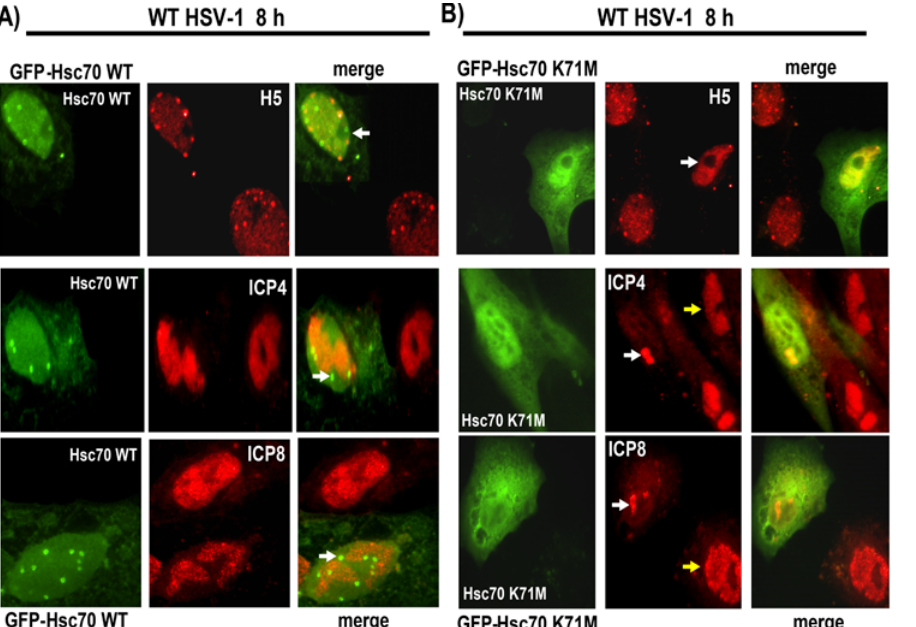
Figure 9. An Hsc70 Dominant Negative Mutant Can Prevent RNAP II Phospho-serine 2 Degradation and Hsc70 Focus Formation. A) Vero cells were transfected with pGFP-Hsc70 and were subsequently infected with WT HSV-1 for 8 h. Cells were stained with H5, anti-ICP4 or anti-ICP8 antibodies. GFP fluorescence was viewed directly. Arrows point to Hsc70 foci. B) Vero cells were transfected with the dominant negative mutant GFP- Hsc70K71M and then infected with WT HSV-1 for 8 h. Cells were stained with H5, anti-ICP4 or anti-ICP8 antibodies. Arrows point to GFP Hsc70K71M expressing cells showing diffuse nuclear staining with H5, and to pre-replication sites in cells stained for ICP4 and ICP8. The yellow arrows in the ICP4 and ICP8 stained panels point to a fully formed replication compartment.